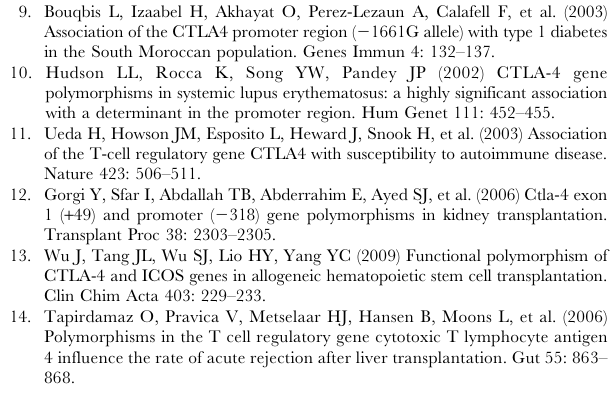
Figure S1 Association between CTLA4 SNPs and early onset of bacterial infection in renal transplantation. No statistical differences for rs733618 (A), rs4553808 (B), rs5742909 (C), rs231775 (D) or rs3087243(E) were found between bacterial infection and non-bacterial infection. (TIF) Figure S2 Association between CTLA4 SNPs and early onset of viral infection in renal transplantation. No statistical differences for rs733618 (A), rs5742909 (C), rs231775 (D) or rs3087243(E) were found between viral infection and non-viral infection. A significant difference (p = 0.001) was found between patients bearing the rs4553808 GG genotype and those with the AA + AG genotypes using the log-rank test (B). (TIF) Table S1 PCR primers of the CTLA4 SNP used in the study. Table S2 Correlation between onset of bacterial infec- tion and CTLA4 genotypes in recipients. Table S3 Correlation between onset of viral infection and CTLA4 genotypes in